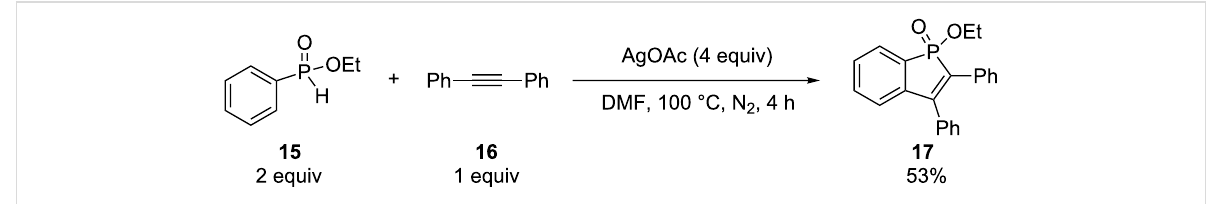
Scheme 8: Silver acetate-mediated alkyne–arene annulation.